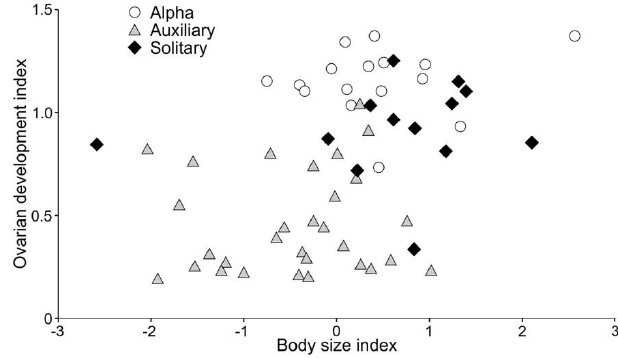
Fig 3. Correlation analyses between the body size index and ovarian development index for foundresses of Mischocyttarus consimilis ( r =0.41; P <0.01).